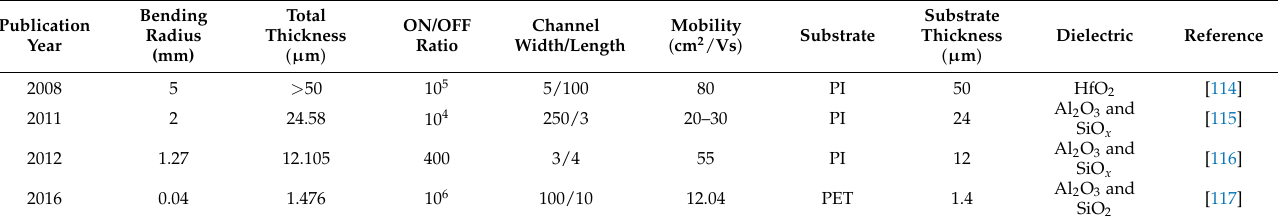
Figure 10. Ultrathin and flexible carbon nanotube electronic sheet, ( a ) laminated onto human skin, and ( b ) rolled-up. ( c ) SEM image of the CNT film laminated over a human hair. Scale bars are ( a ) 2 cm, ( b ) 1 cm, and ( c ) 150 µ m. [117]. Reproduced with permission. Table 4. The detailed properties of the SWCNT TFTs in Figure